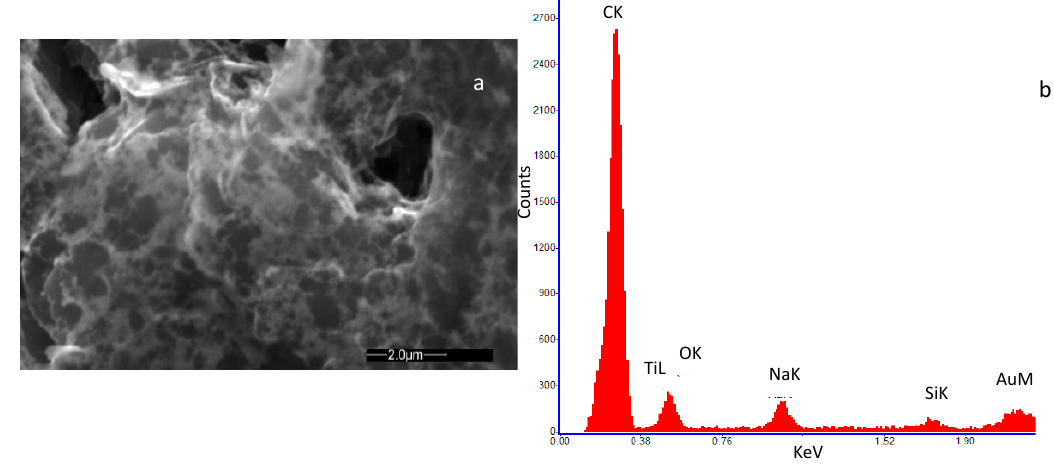
Figure 2. High-resolution field emission scanning electron microscopy (SEM) image of the deposited film of SWCNTs decorated by Au nanoparticles. The microscopic investigation was performed with a Quanta 400 (FEI) emission scanning electron microscope, operated at 20.0 kV. ( a ) view of the deposited film; ( b ) result of the Energy Dispersive Spectroscopy (EDS) on the analyzed sample.